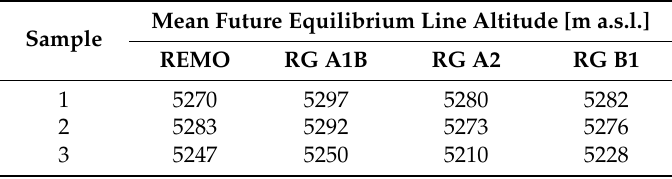
Table 6. Mean equilibrium line altitude for the Future Period simulations.